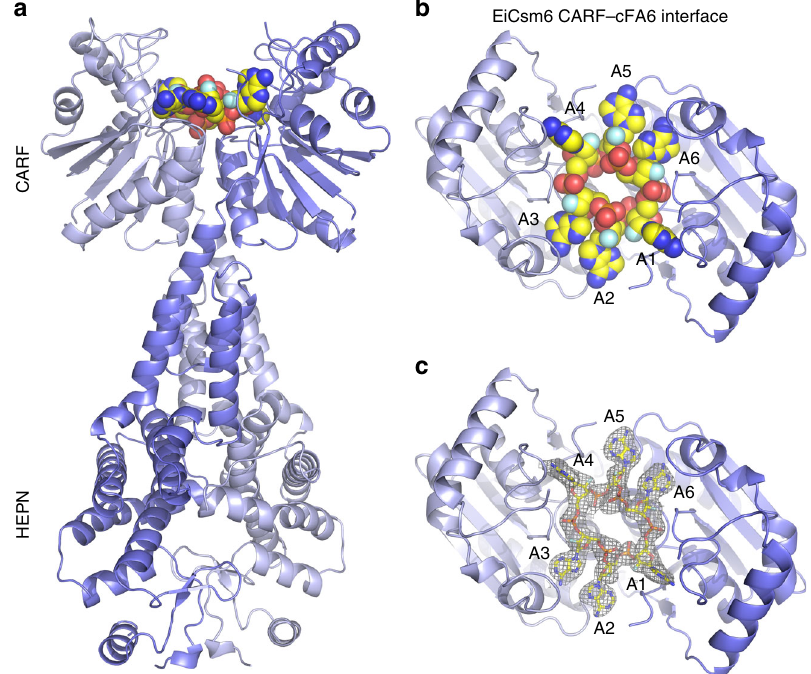
Fig. 1 Cyclic hexaadenylate recognition by EiCsm6. a , b Overall structure of EiCsm6 homodimer bound to cFA6, shown in two orientations ( a : side view of the EiCsm6 homodimer; b : view of the cFA6 binding site at the CARF domain interface). The EiCsm6 homodimer is shown in cartoon representation (with protomers colored light and dark blue). cFA6 is depicted in sphere format. c Zoom-in view of the cA6 binding site at the CARF domain interface of EiCsm6, showing a 2m F O – D F C composite omit map, contoured at 1.0 σ and displayed within a radius of 2.2 Å around